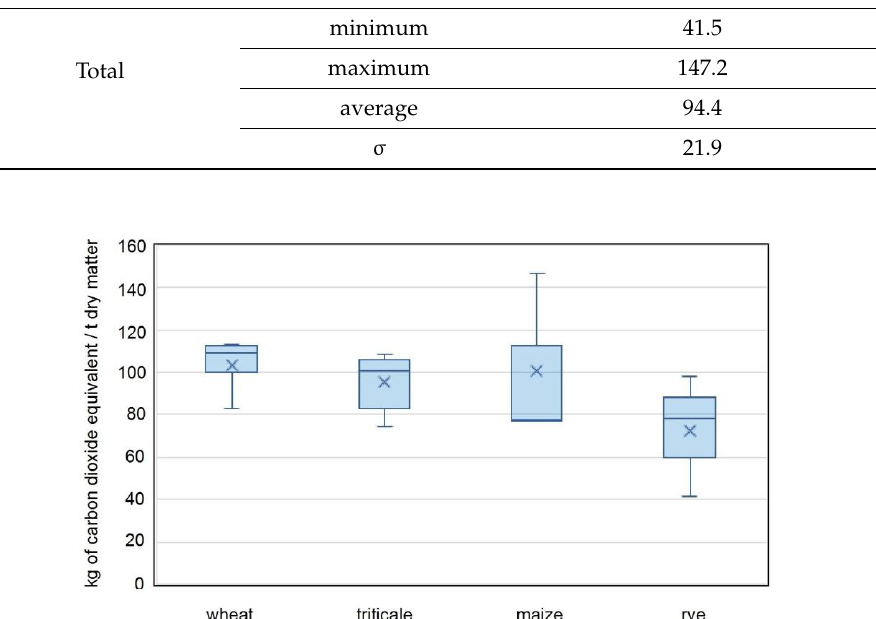
Table 3. GHG emissions from cultivation of agricultural crops for biofuels (e ec ).